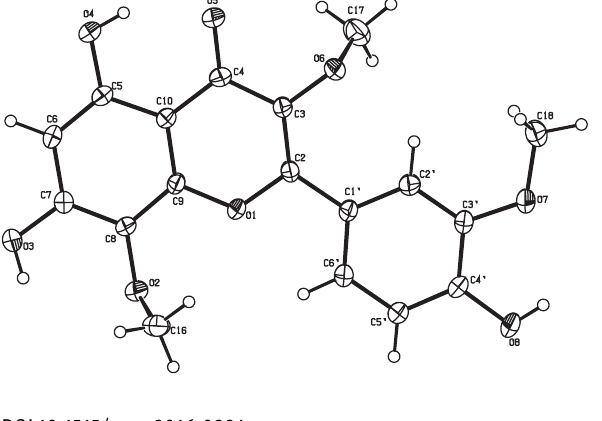
Table 2: Fractional atomic coordinates and isotropic or equivalent isotropic displacement parameters (Å 2